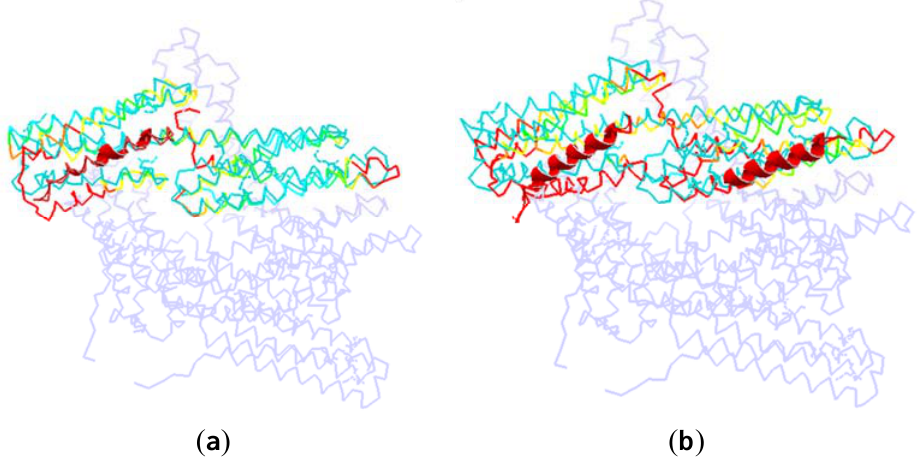
Figure 7. The dorsal view of the complex structure that vinculin is bound to other partners. ( a ) The D1 domain interacted with other partner at only one binding site, (take protein 1RKC as an illustration); ( b ) The D1 domain interacted with other partners at two binding sites (take protein 2IBF as an